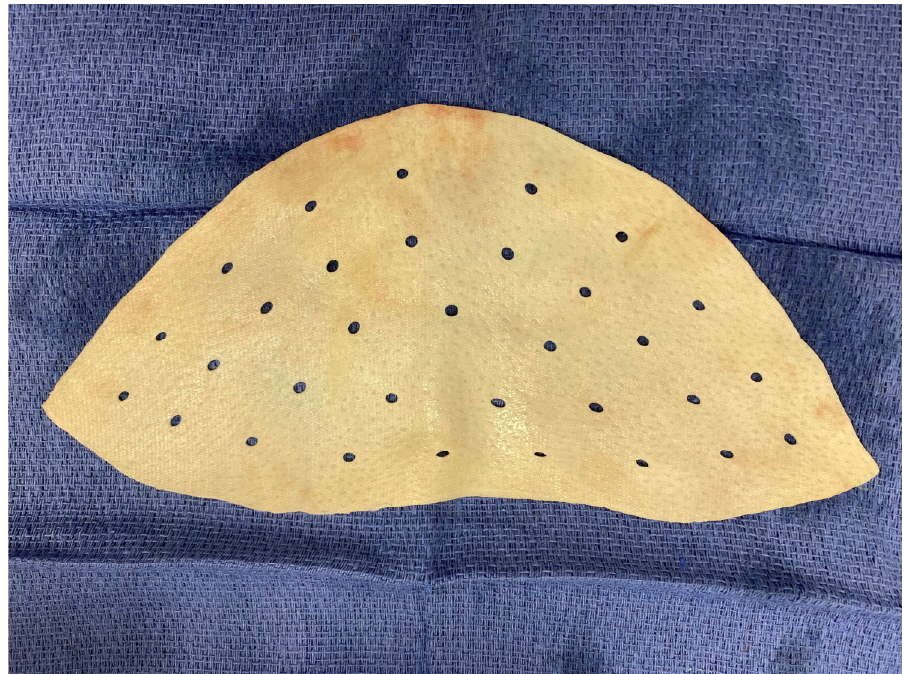
Figure 5. The ADM patch used (one for each breast) to cover the superior-anterior part of the im- plant. AlloDerm SELECT Regenerative Tissue Matrix, Contour Medium Perforated, thickness medium 1.6 mm ± 0.4 mm was used (ALLODERM and its design are trademarks of LifeCell Corporation, an AbbVie company).